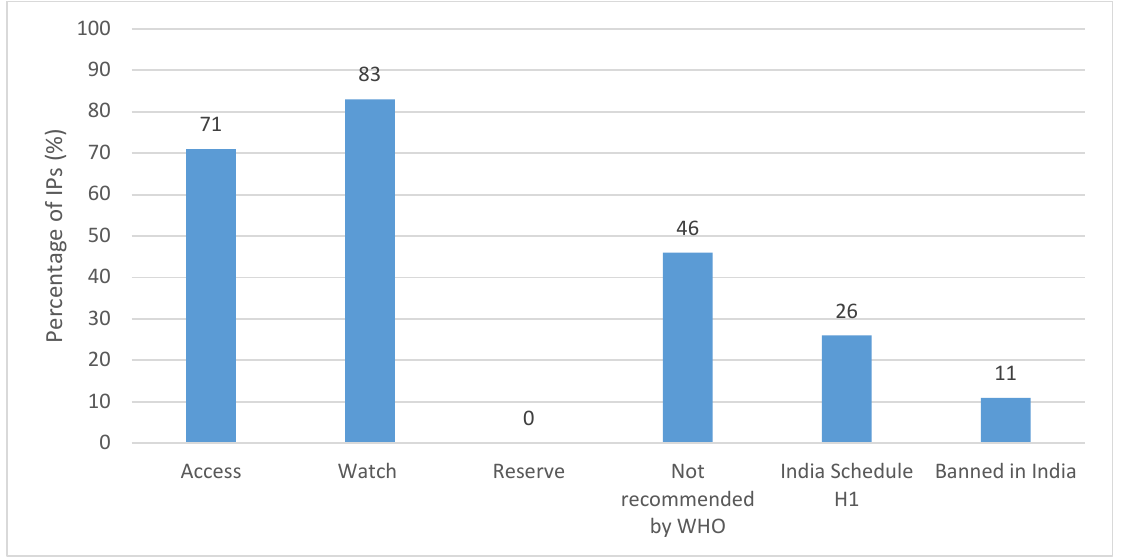
Figure 3. Percentages of IPs stocking antibiotics by WHO AWaRe classification and Indian regulatory* status (N = 196).